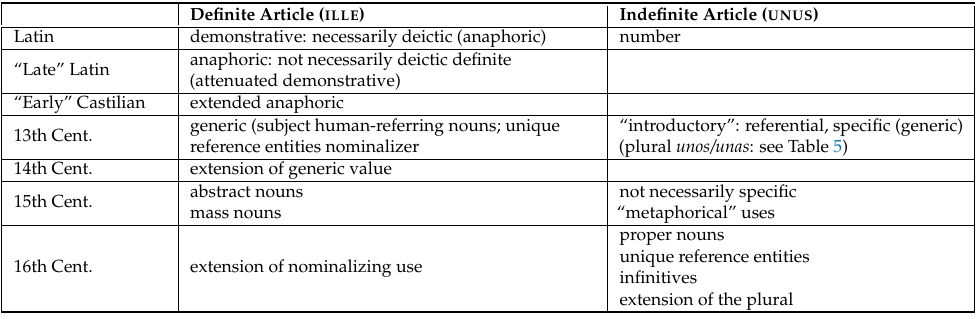
Table 2. Functional extension of the Castilian articles (based chiefly on Company Concepci ó n 1991, Garachana Camarero 2009 and Ortiz Ciscomani